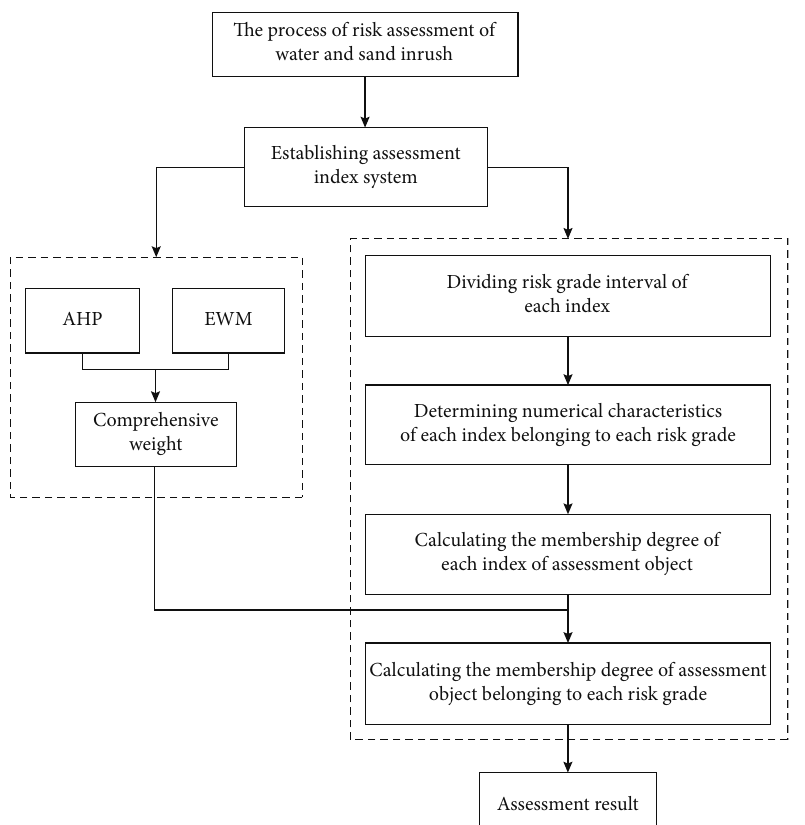
Figure 1: The process of using the comprehensive weight-cloud model method to assess the risk of water and sand inrush during mining under loose layers.